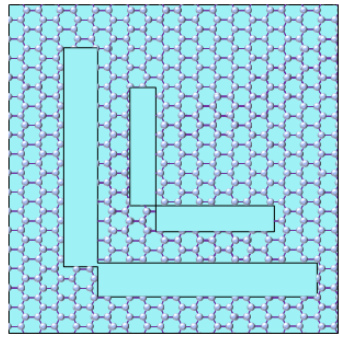
Figure 8. Graphene-based terahertz metamaterial polarization converter composed of graphene monolayer etched with pairs of rectangles